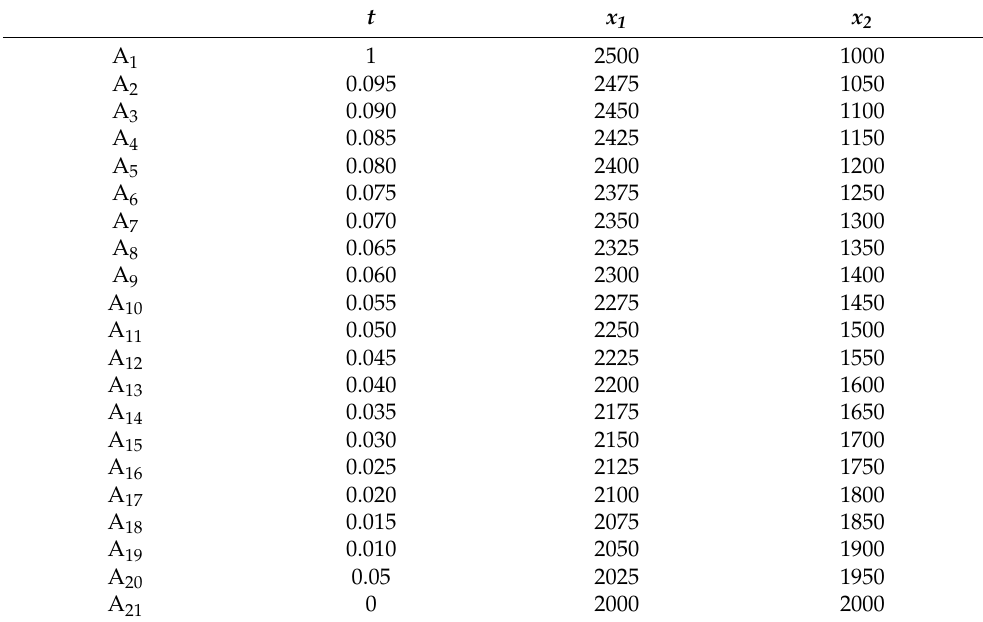
Table 3. Defining alternatives depending on the value t .